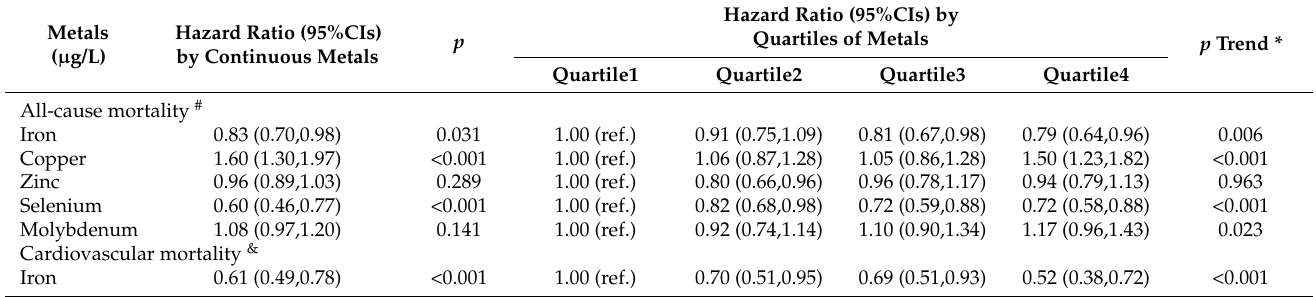
Table 2. Hazard ratios (95%CIs) for all-cause and cardiovascular mortality in patients with type 2